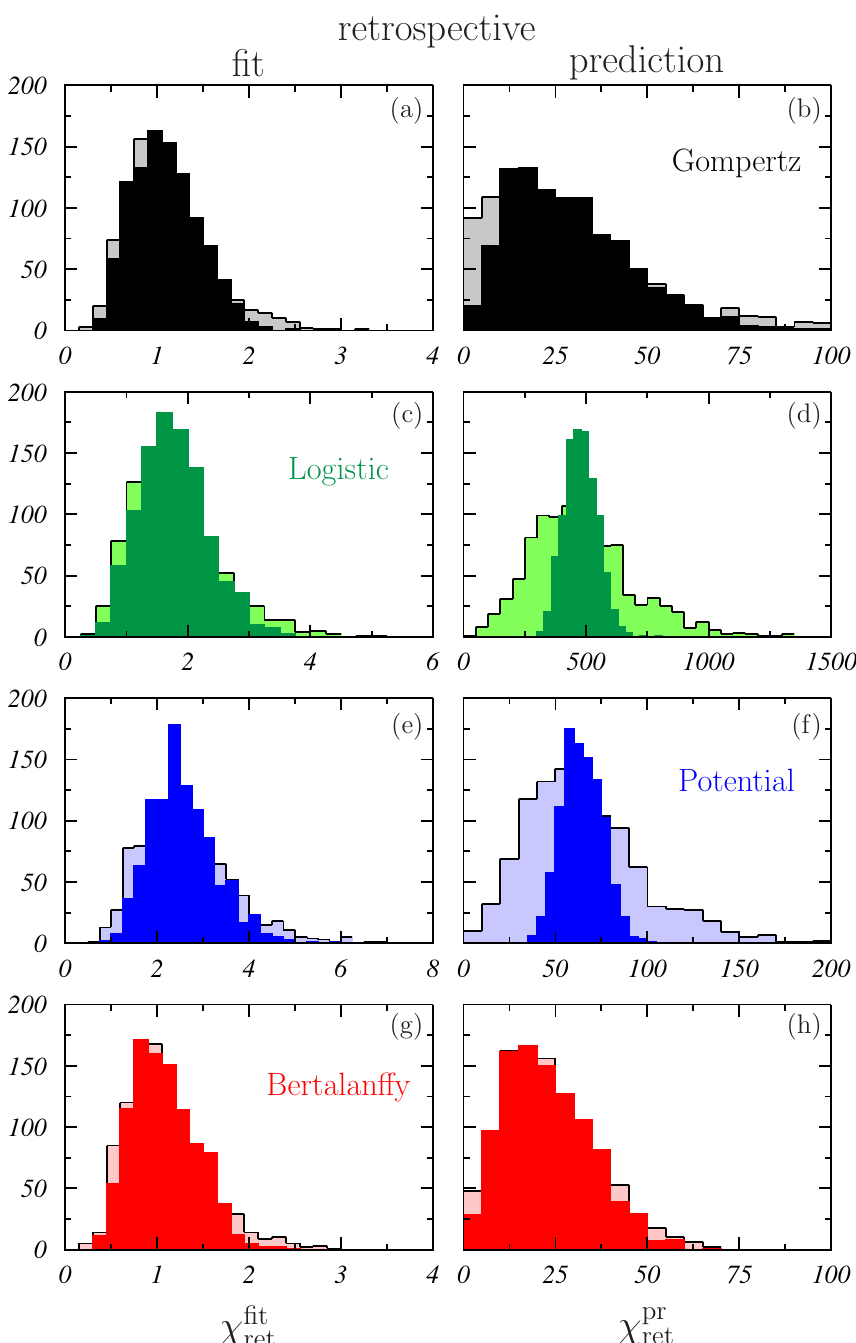
Figure 5. Distribution histograms of the values of χ ret obtained in the retrospective fits of the four mathematical models considered to the simulated MTS in samples #1 (dark colors) and #2 (light colors). Left panels correspond to the fits to data in the time interval [40–60] day and right panels to the retrospective fits to data in the time interval [20–39] day. The results obtained for the Gompertz ( a , b ), logistic ( c , d ), potential ( e , f ) and Bertalanffy ( g , h ) models are